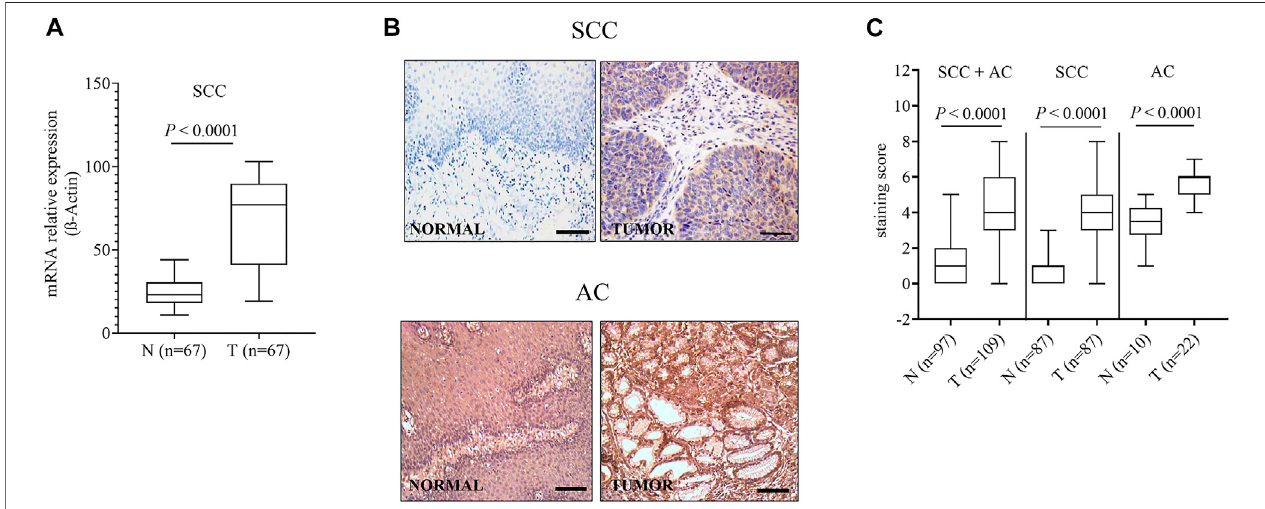
FIGURE3| OCTN2expressionlevelinsquamouscellcarcinoma(SCC)andadenocarcinoma(AC)samples.OCTN2mRNAvaluesnormalizedbytheexpressionof the housekeeping gene b-actin (A) . Representative immunostaining of SCC and AC and the respective paired normal tissues. Scale bar (cid:1) 100 µm (B) . Relative quanti fi cation of the OCTN2 staining per high-power fi eld. All comparisons were performed by Mann-Whitney test (C) .